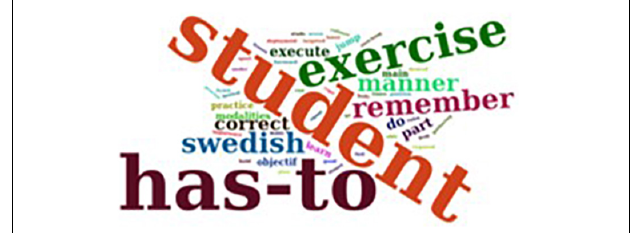
FIGURE 4 | Words clouds about